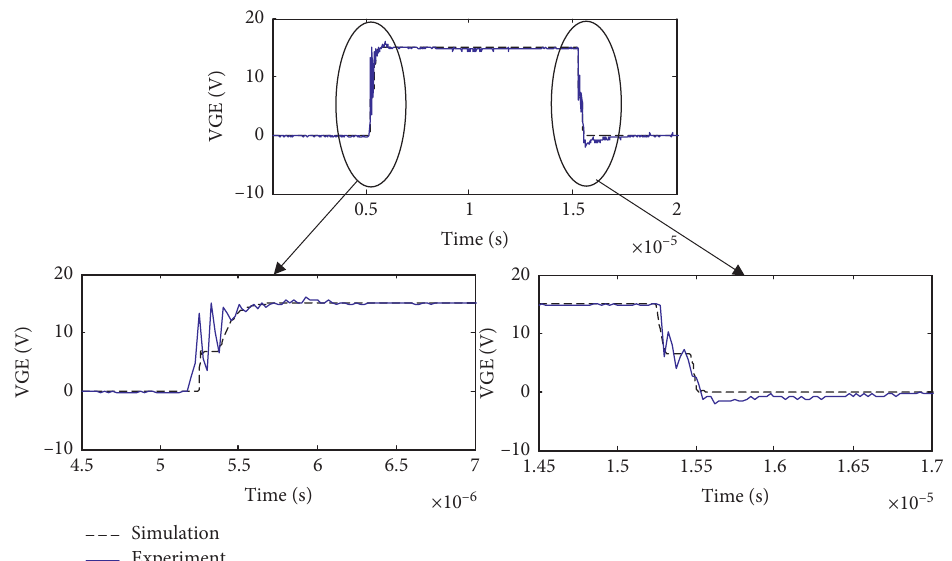
Figure 12: V GE waveforms of experimental and simulated dynamic IGBT (IRGBC20U) behaviour.